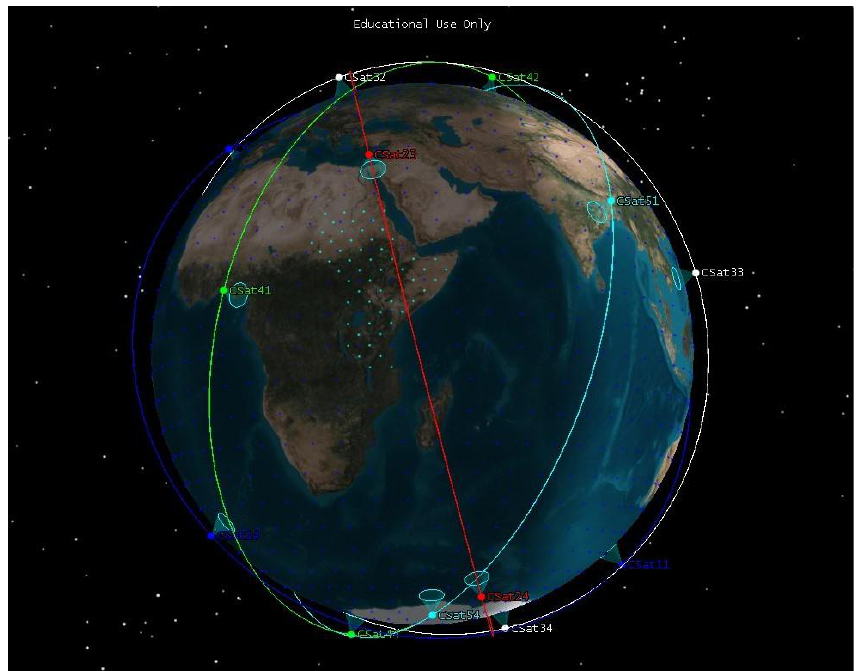
Figure 9. CubeSat constellation model for solution number 20.